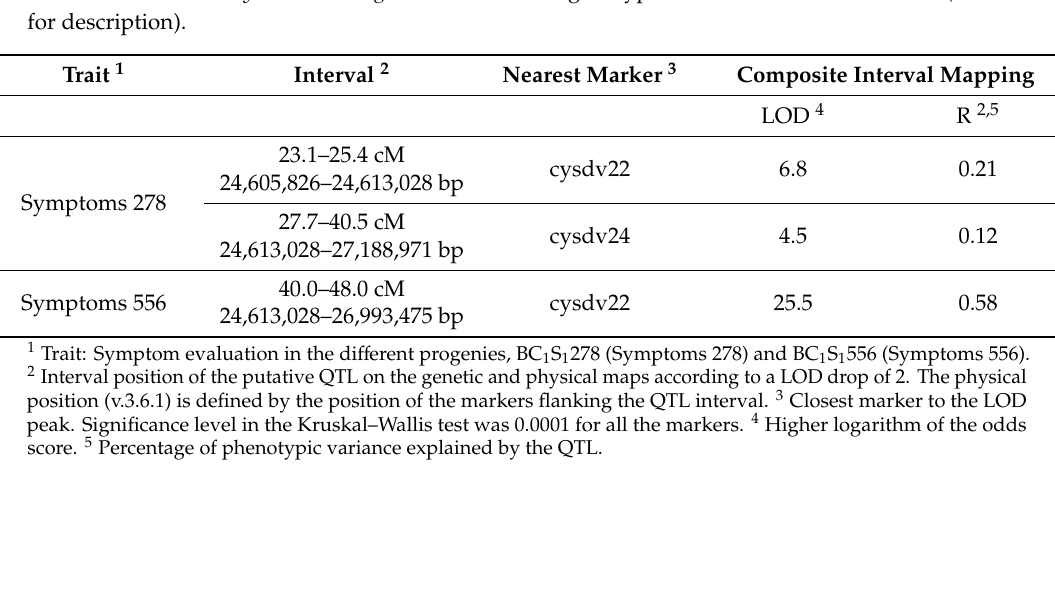
Figure 1. Map of the region of chromosome 5 involved in resistance to Cucurbit yellow stunting disorder virus (CYSDV) generated with data from ( a ) the RIL populations genotyped by genotyping by sequencing (GBS), ( b ) the BC 1 S 1 278 population genotyped with the marker set CYSDV1, ( c ) the BC 1 S 1 556 population genotyped with the marker set CYSDV1, and ( d ) the BC 1 S 1 556 population genotyped with the marker sets CYSDV1 and CYSDV2. The QTLs obtained in each of the assays are represented by bars. Markers defining the most important QTLs are indicated in red to facilitate comparison of the different maps. See text and Tables 1–3 for description of the traits analyzed. Table 2. Quantitative trait loci (QTLs) identified in chromosome 5 in BC 1 S 1 progenies of RILs 278 and 556 derived from the cross between TGR-1551 and the cultivar ‘Bola de Oro’, phenotyped for resistance to Cucurbit yellow stunting disorder virus and genotyped with markers set CYSDV1 (see text for description).